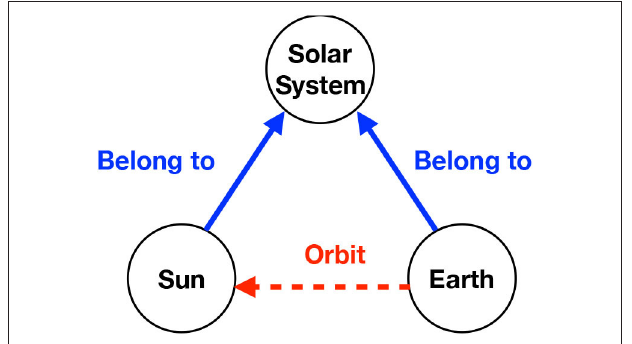
FIGURE 1 | An example of the MRN representation of a knowledge